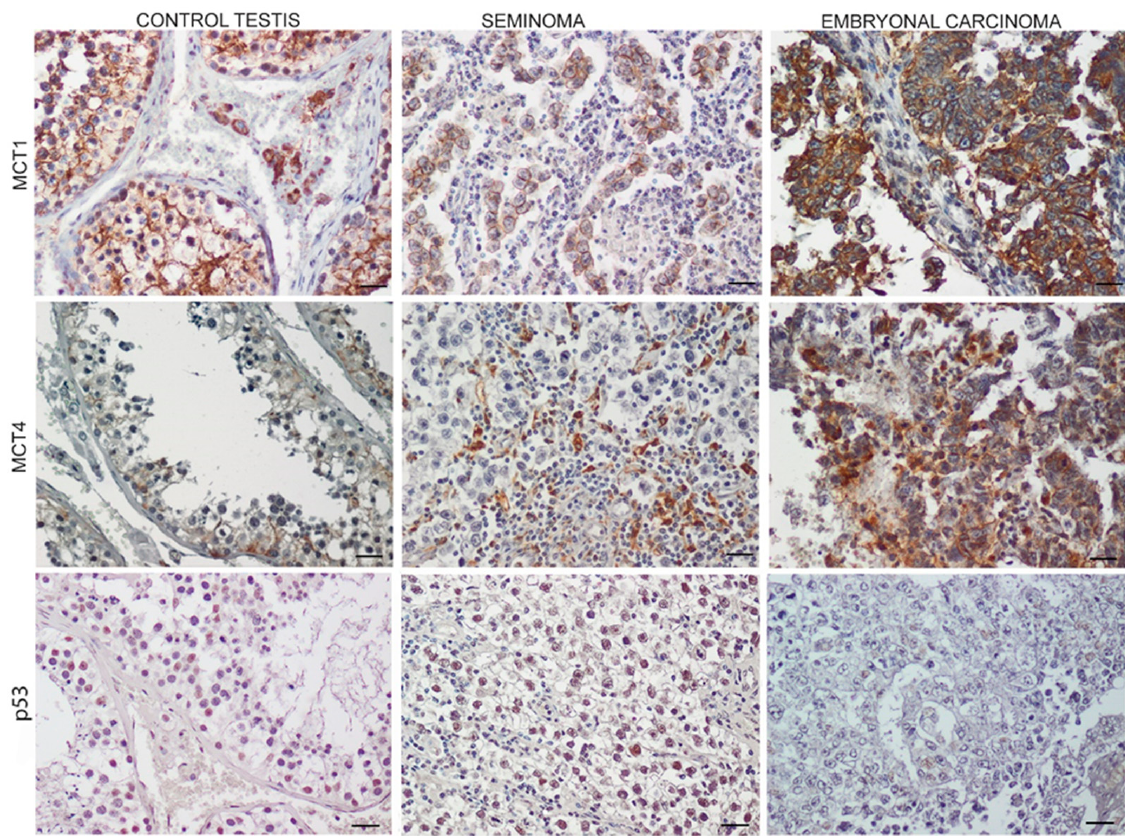
Figure 3. Expression of monocarboxylate transporters 1 (MCT1), monocarboxylate transporters 4 (MCT4), and p53 in control testis and TGCTs Scale bars: 25 μ m. Table 2. Monocarboxylate transporters 1, 4, and p53 immunoreactivity in control and TGCTs.